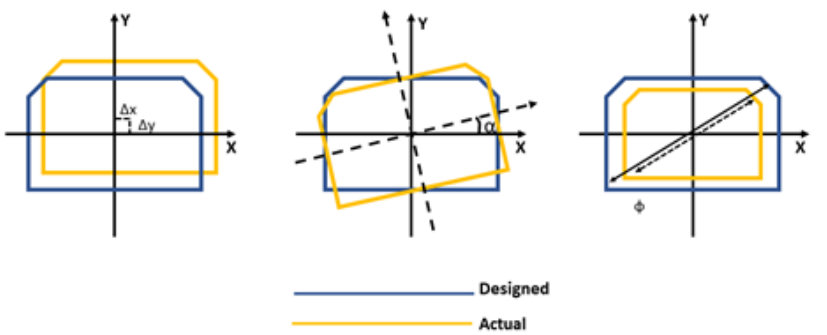
Figure 10. Variation of product’s geometrical shape in 2D form.